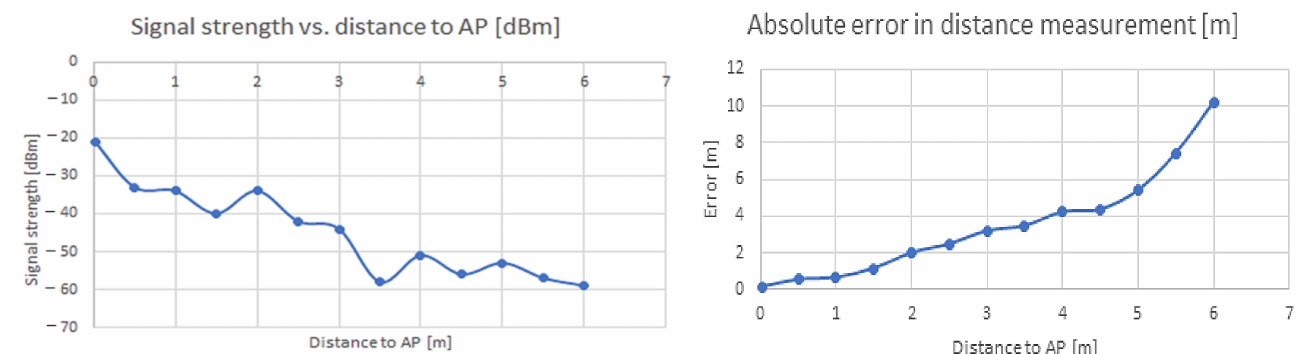
Figure 10. Variation in received signal strength with distance ( left ) and absolute error in distance measurements ( right ), Xiaomi AP, mixed indoor environment (LoS + NLoS).